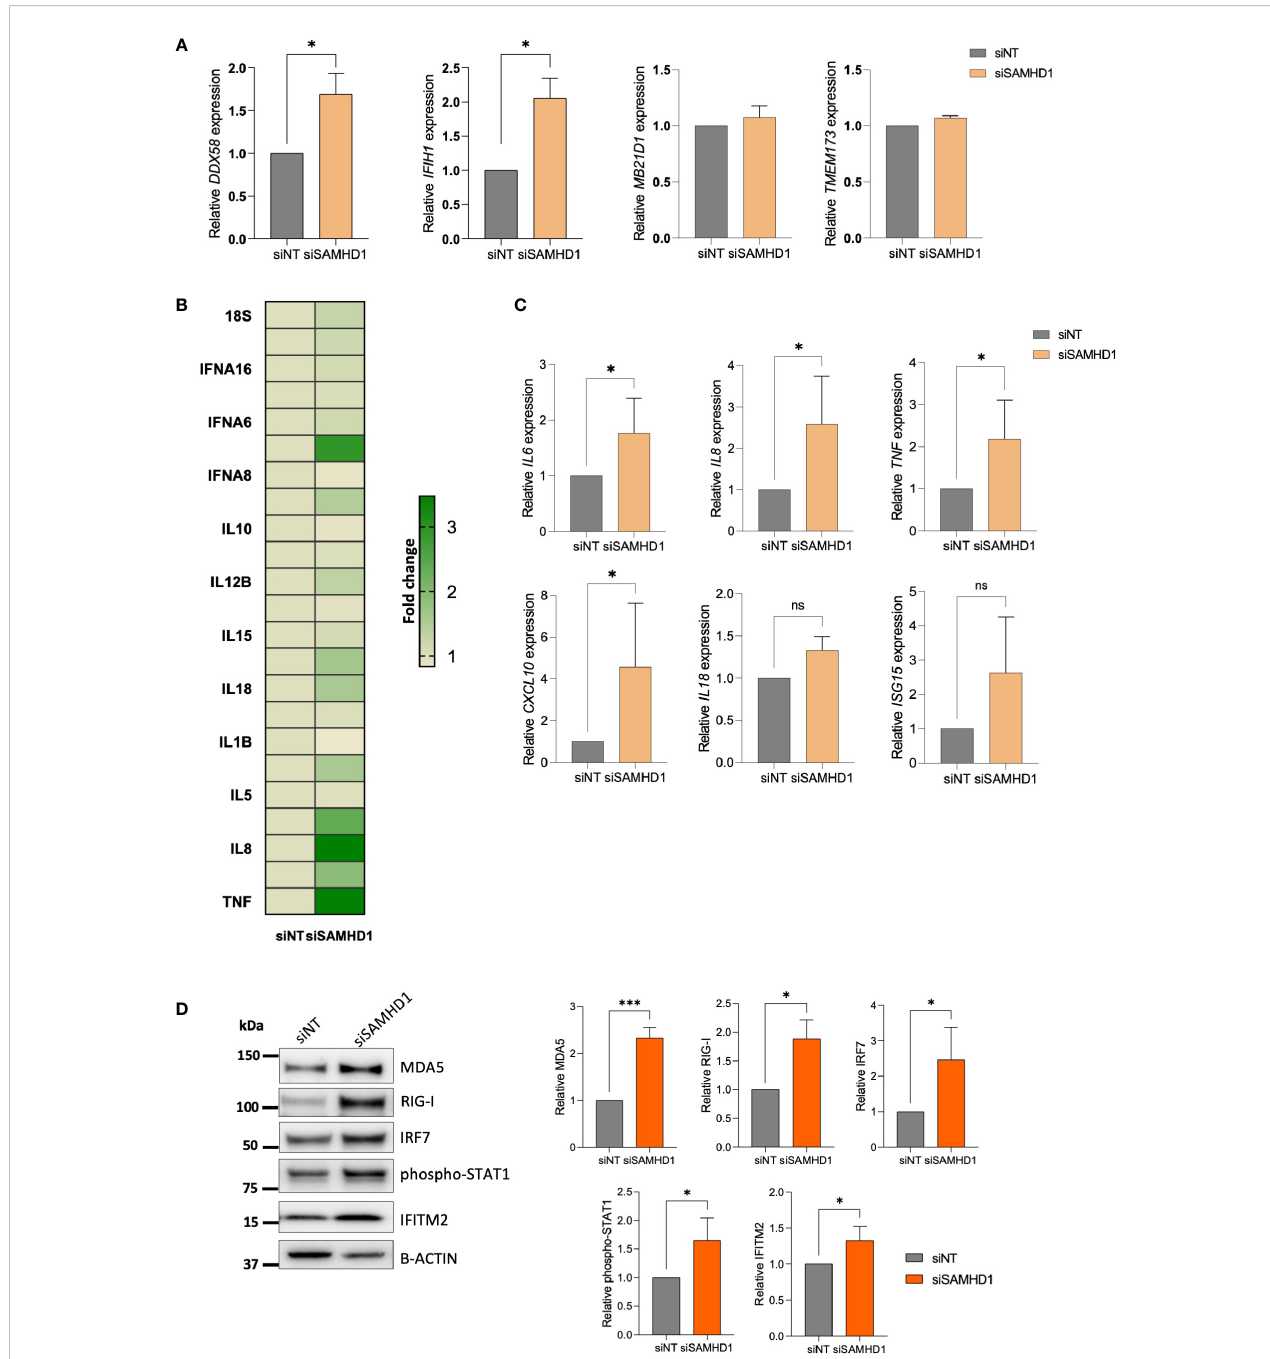
FIGURE 2 SAMHD1 knockdown modulates RLR (RIG-I like receptor) expression and innate immune signaling. (A) Gene expression of DNA sensors ( MB21D1 encoding cGAS protein, TMEM173 encoding STING protein) and RNA sensors ( DDX58 encoding RIG-I protein, IFIH1 encoding MDA5 protein), upon SAMHD1 knock-down. (B) SAMHD1 knockdown induces proin fl ammatory cytokine expression. Heatmap showing fold change increase expression in siSAMHD1 cells compared to non-targeting control, evaluated using the TaqMan Human Cytokine Network array. (C) Gene expression of distinct IFN- stimulated genes (ISG) in SAMHD1 knockdown cells. Increased IL6 , IL8 , TNF , IL18 , CXCL10 and ISG15 expression upon SAMHD1 depletion was con fi